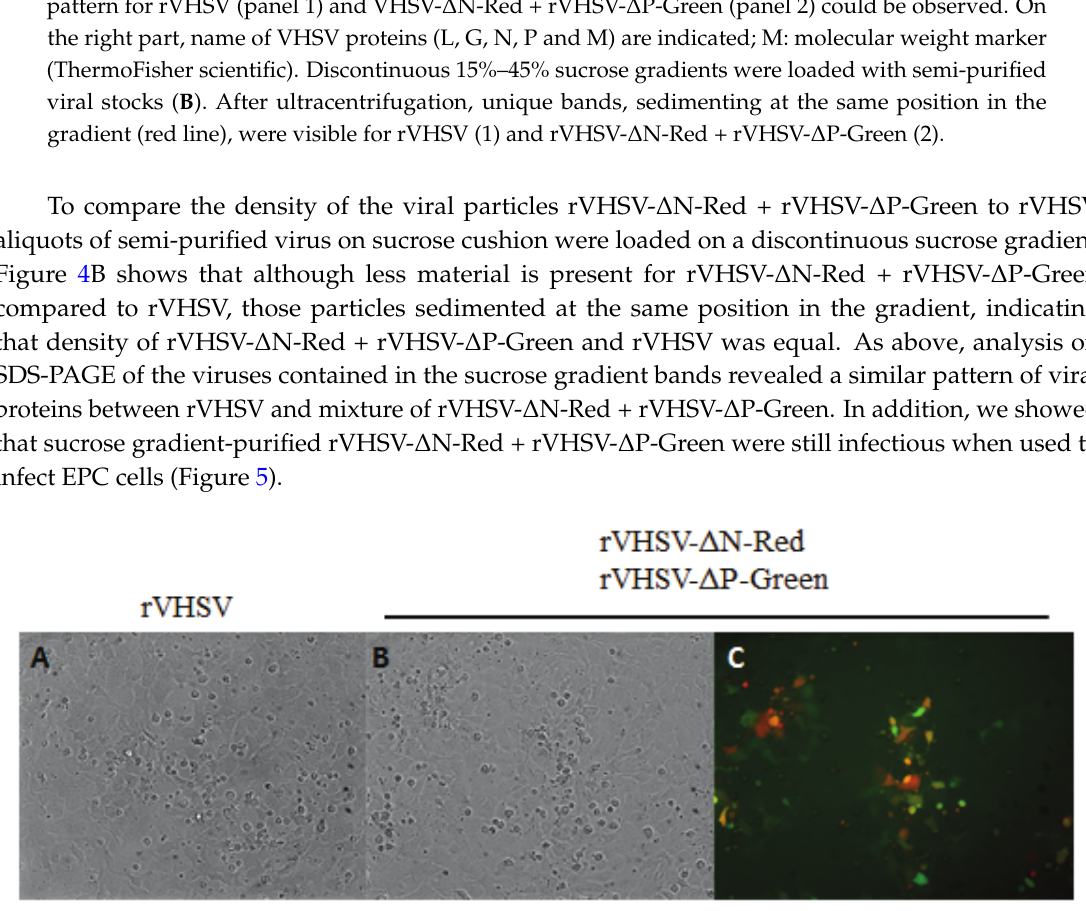
Figure 5. Infection of EPC cells with sucrose gradient-purified recombinant viruses. EPC cells in 24-well plates were infected (m.o.i. = 1) with rVHSV or rVHSV- Δ N-Red + rVHSV- Δ P-Green purified on sucrose gradient (see Figure 4B). Infected cells were observed two days post-infection either under phase-contrast (rVHSV and rVHSV- Δ N-Red + rVHSV- Δ P-Green, A and B , respectively) or UV-light microscope (rVHSV- Δ N-Red + rVHSV- Δ P-Green, C ). Overlapping of Red and Green fluorescence is presented showing that majority of the infected cells were yellow (Red + Green).